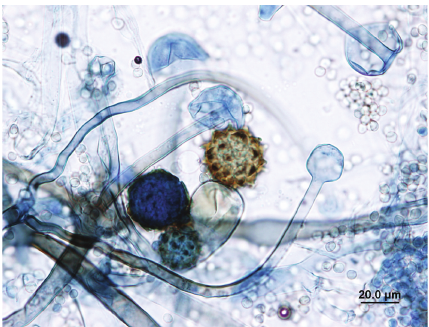
Figure 5: Photomicrograph of sporangiophores and mature azy-